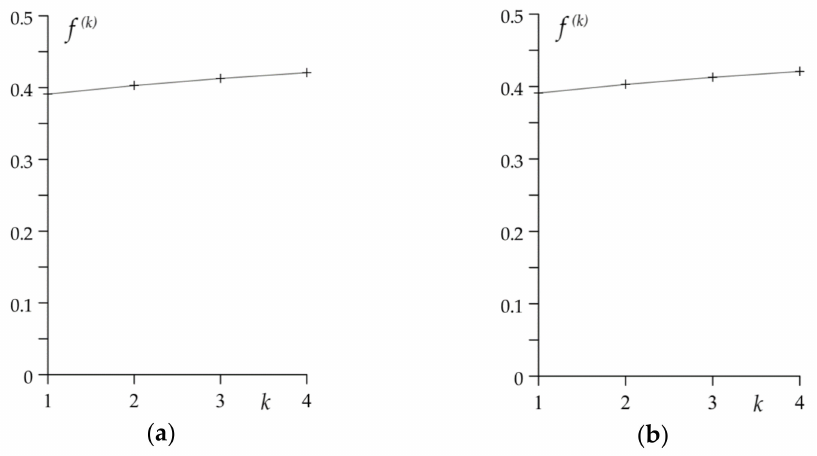
( k ) s for the drum brake in